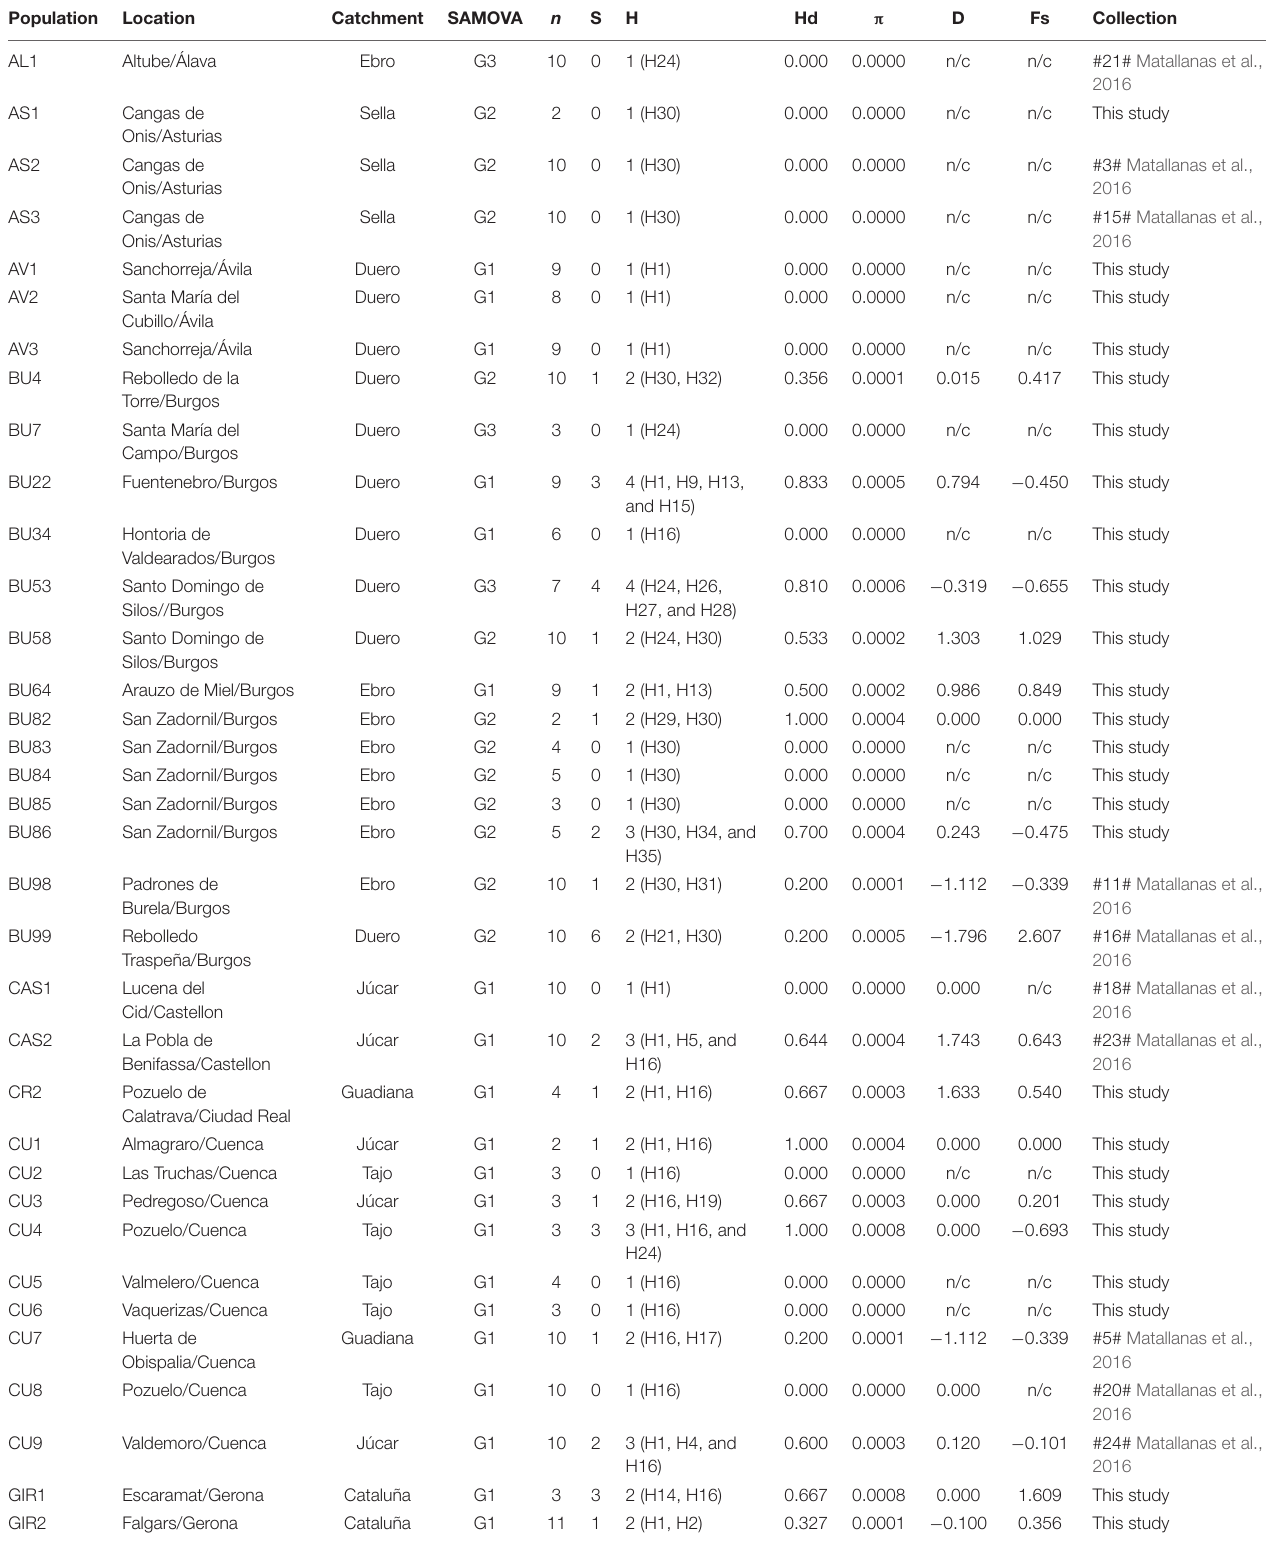
TABLE 1 | Populations and locations of the white-clawed crayfish analyzed in the present work ( Figure 3 ). Population